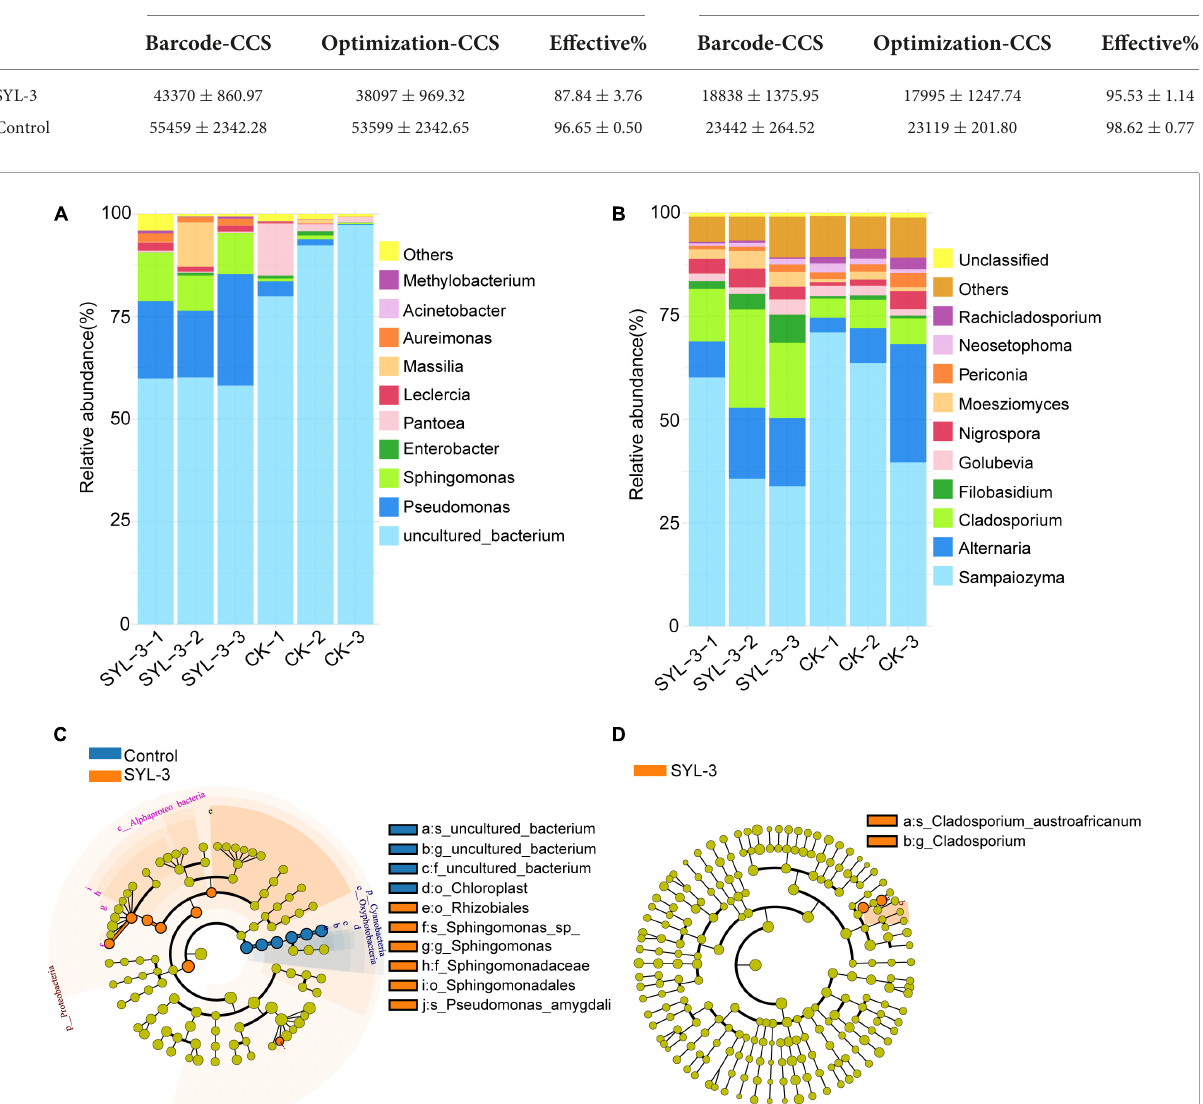
TABLE 2 Statistics of sample sequencing data processing result.